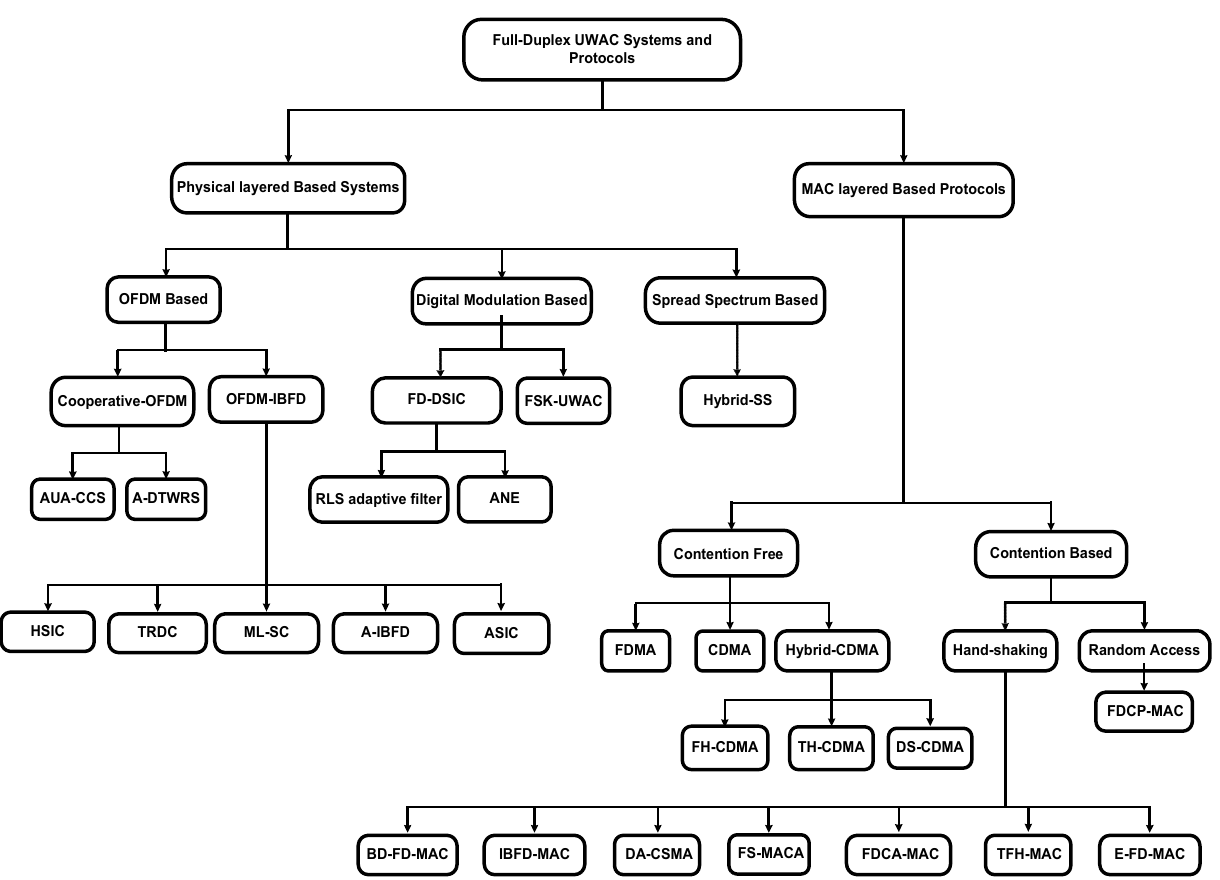
Figure 1. Classification of full-duplex physical layered UWAC systems and MAC layered protocol.